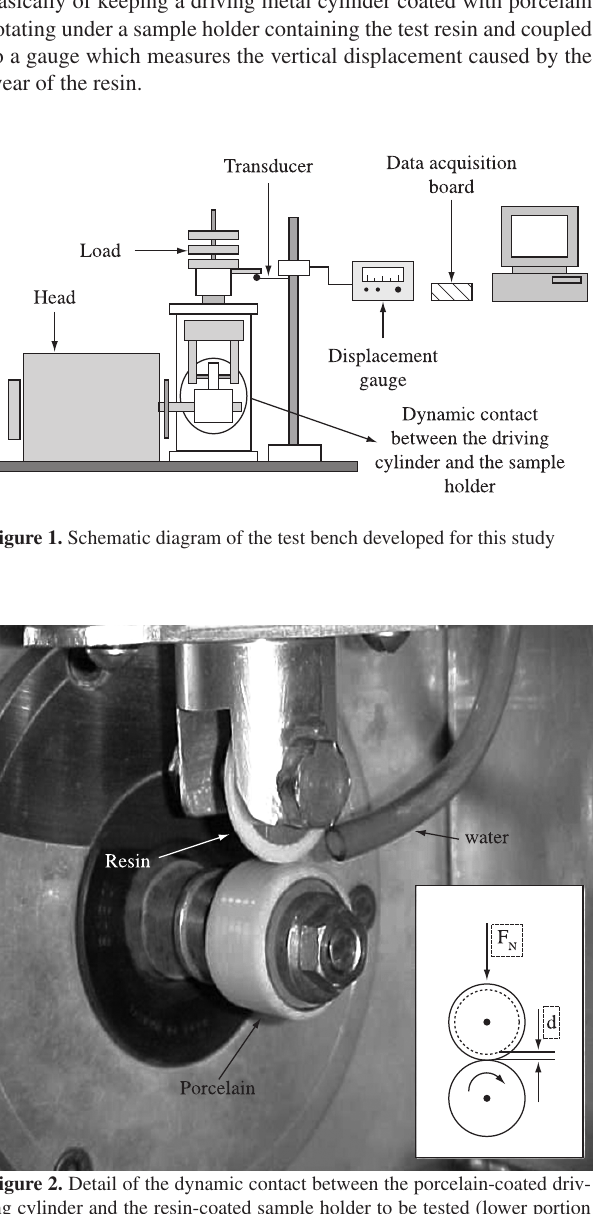
Figure 4. Sample holder with and without the polymerized test